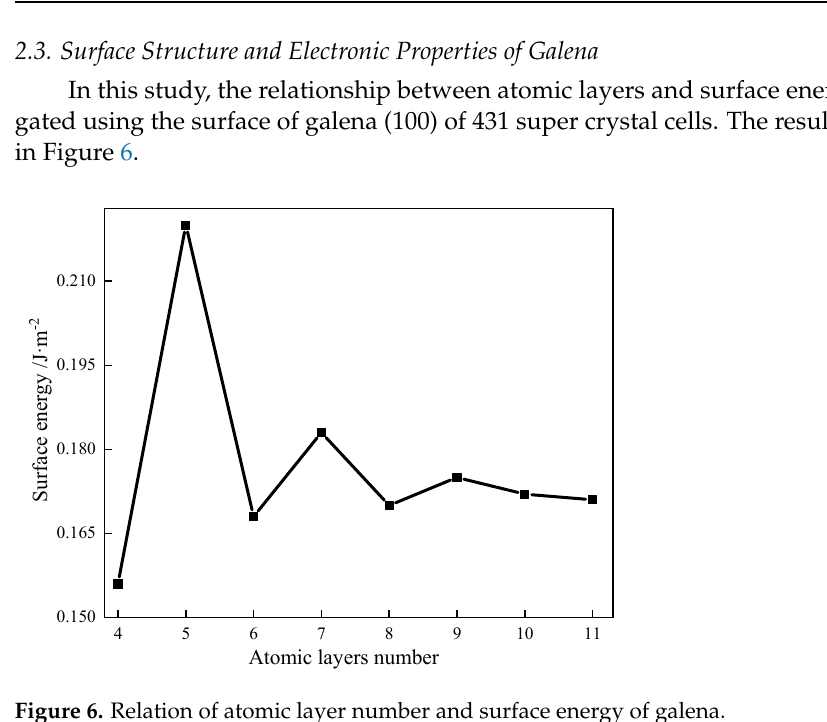
Table 6. The displacement of the three layers of atoms on the galena surface before and after opti- mization.